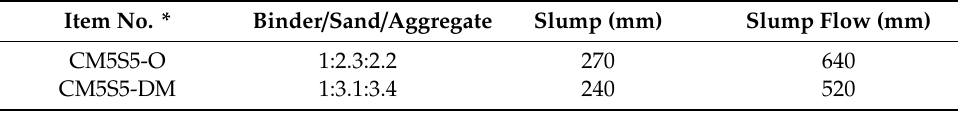
Table 3. Fresh properties of marble-based geopolymer concrete.